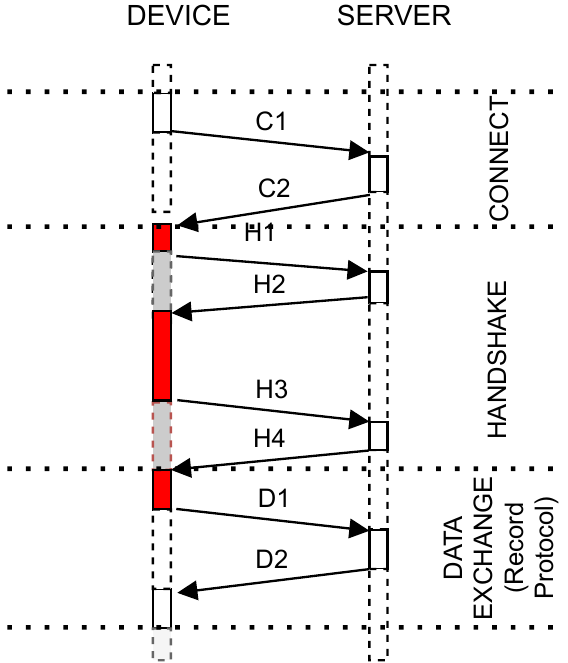
Figure 4. Examples of messages between a device and a server when using